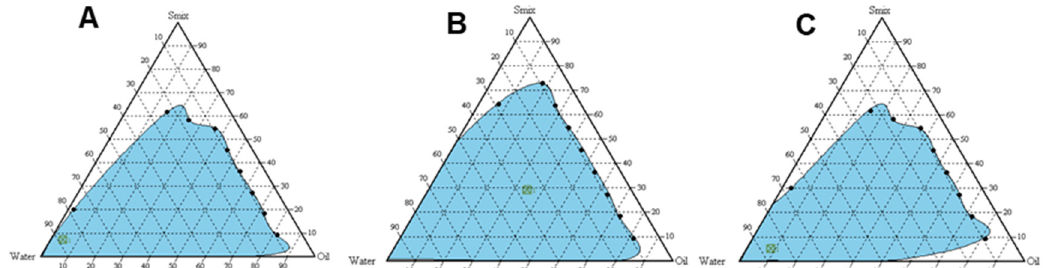
Figure 2. Pseudo-ternary phase diagrams indicating the efficient self-emulsification region. ( A ) Smix 1:1, ( B ) Smix 1:2; ( C ) Smix 2:1.